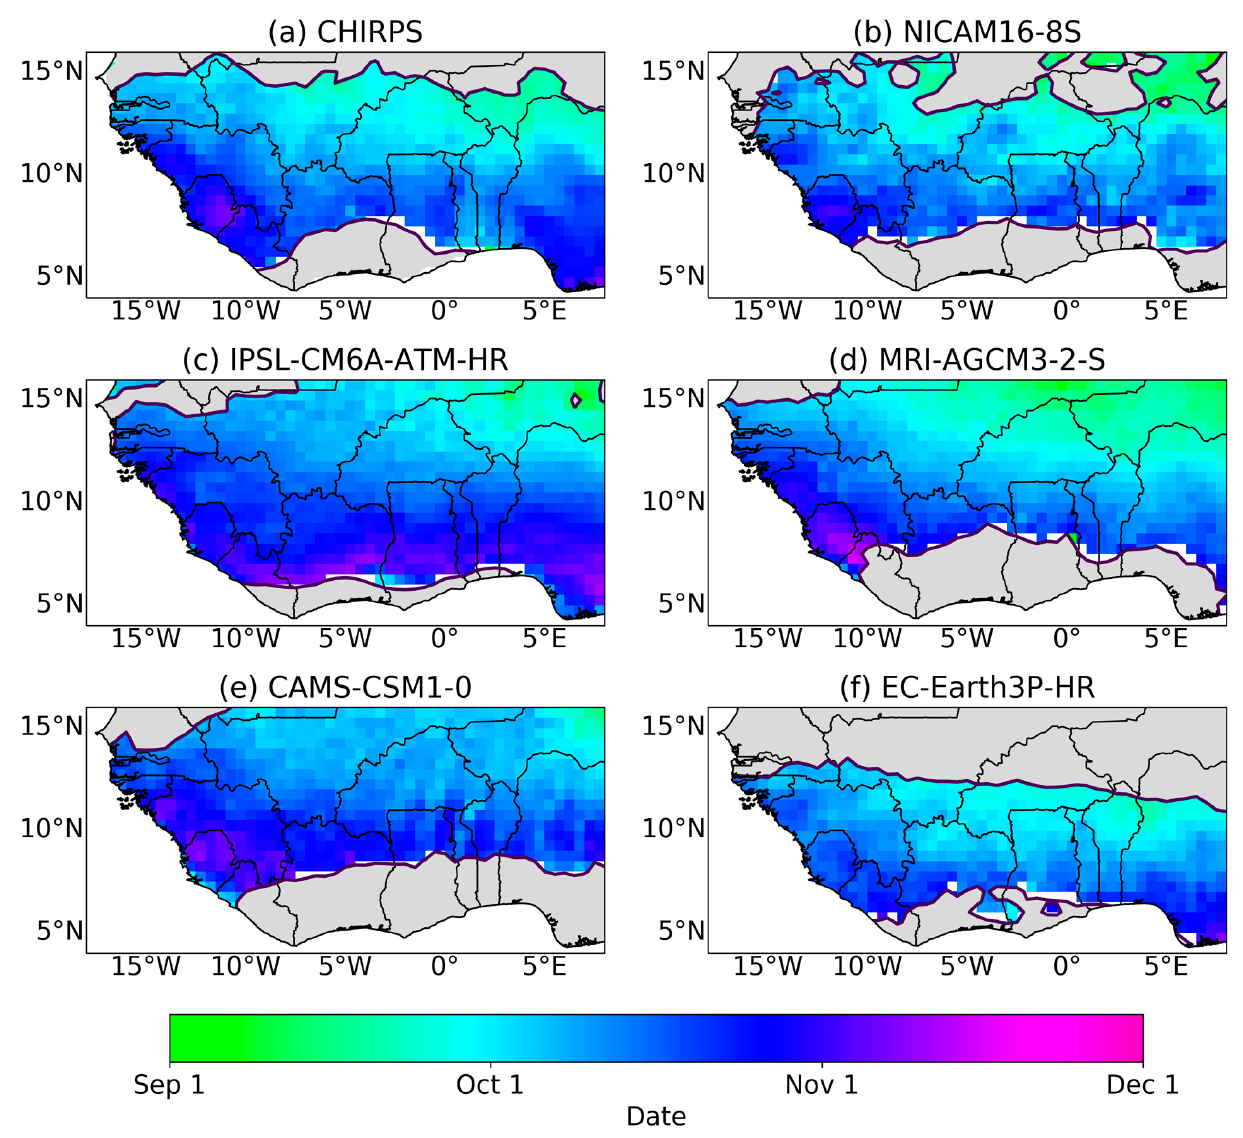
Figure 3. Mean cessation date for unimodal regime regions for all data sets. Dark grey at the south indicates regions with bimodal regimes and grey at the north indicates dry regions.